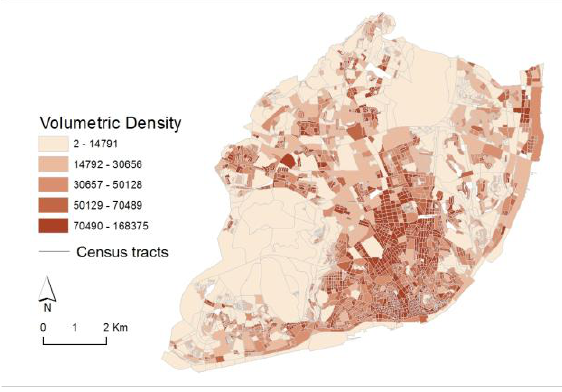
Figure 6. Volumetric Density (m 3 /ha) in Lisbon city, calculated at the block-level